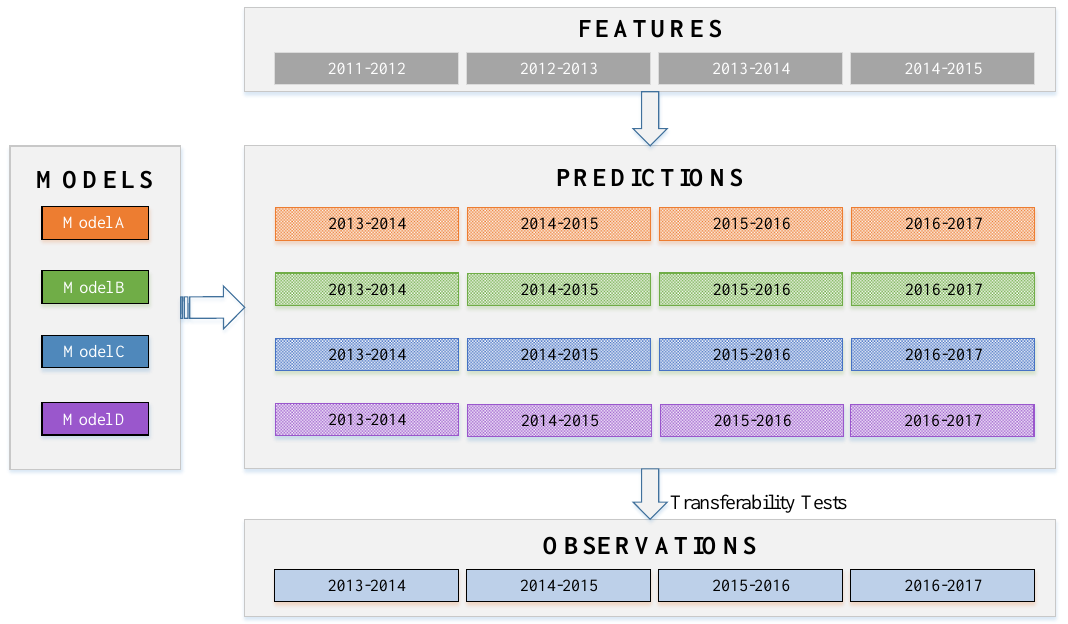
Figure 9. Temporal transferability tests of four trained models